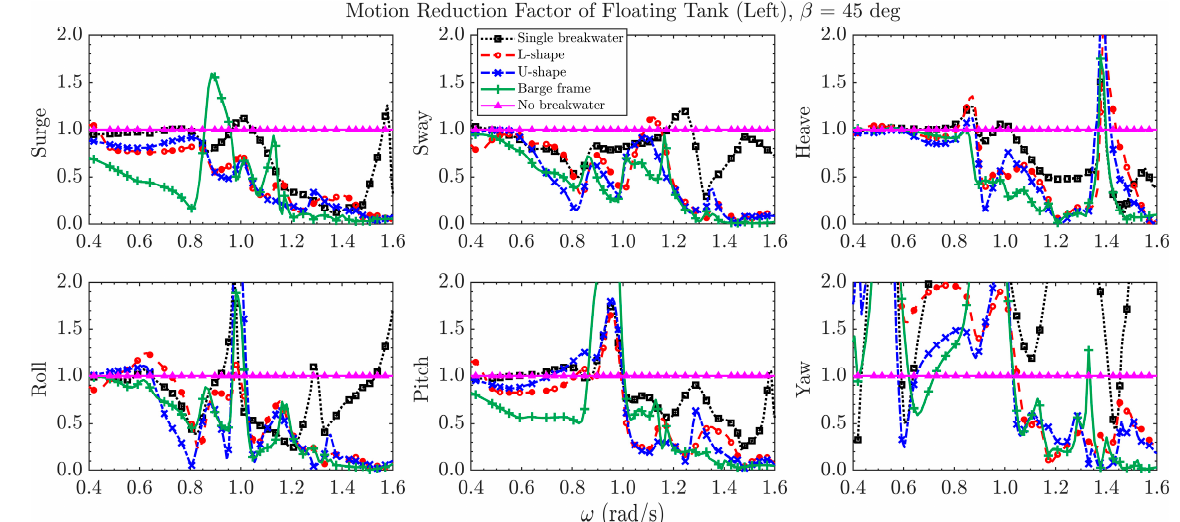
Figure 15. Effectiveness of the floating breakwater in motion reduction of the floating tanks in 45 deg incident wave direction.